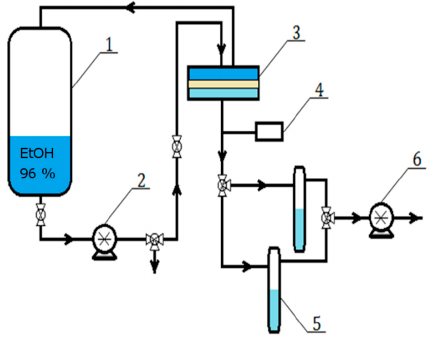
Figure 2. Scheme of pervaporation setup: 1—feed tank, 2—circulation pump, 3—separation chamber, 4—vacuum gauge, 5—cooled collection traps and 6—vacuum pump.